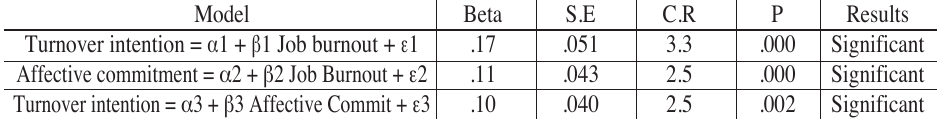
Affective Commitment Mediates b/w Job Burnout and Turnover Intention